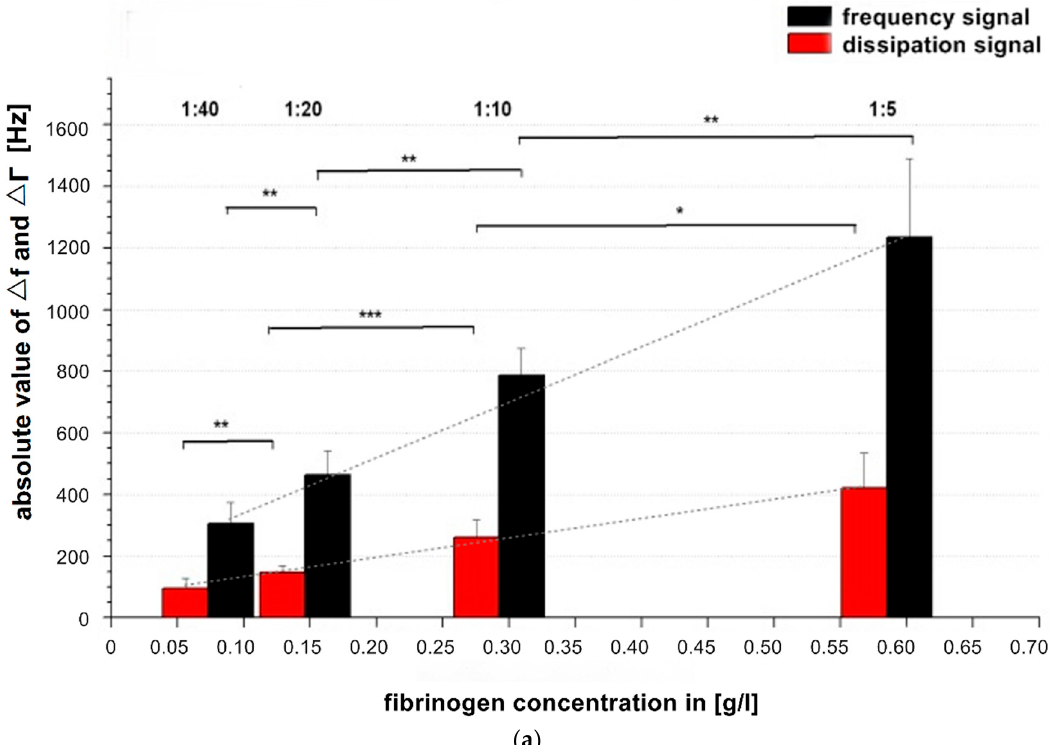
Figure 3. Cont . Figure 3.